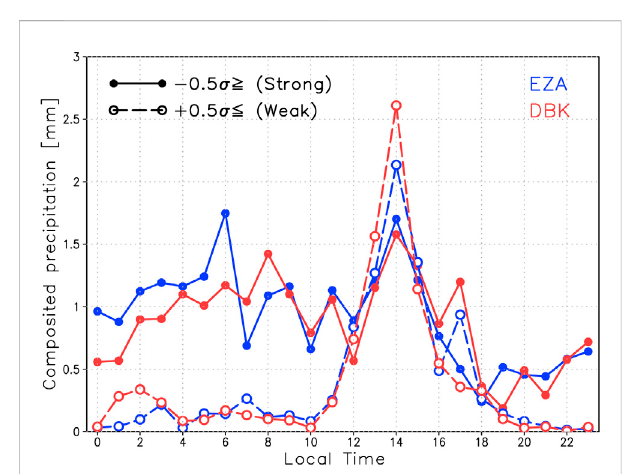
FIGURE 9 Composited precipitation in August at Esperanza (blue) and Dos Bocas (red). The thick solid lines (thick dashed lines) were derived whenboththeeasterly andnortherly winds(at925 hPa)oftheJRA-55 reanalysis were relatively strong (weak) over the area 75 ° – 85 ° W, 10 ° – 12.5 ° N (red rectangle in Figure